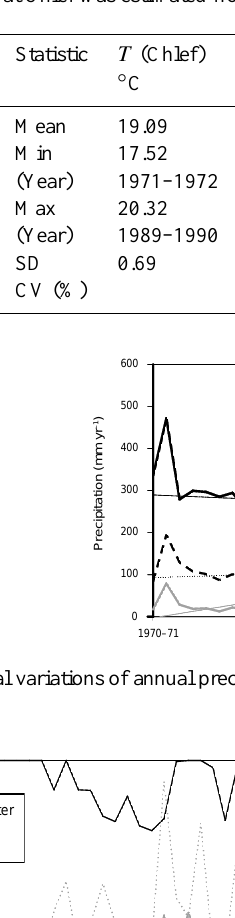
Table 1. General statistics on the yearly averages of hydrologic parameters from the Wadi Abd at Ain Hamara gauging station over the period 1970–2010 (note: T at Chlef was estimated from measurements at Dar El Beida and Miliana for 20 months over 480 months).